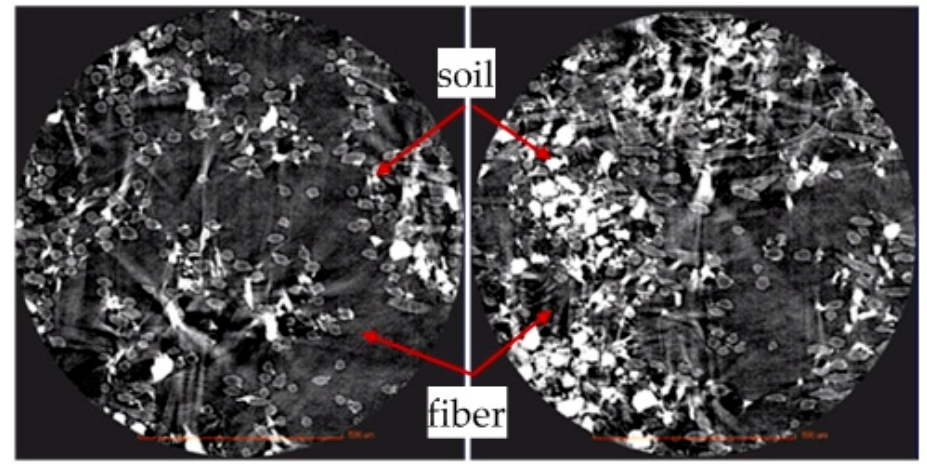
Figure 11. Nonwoven geotextile B after artificial clogging.